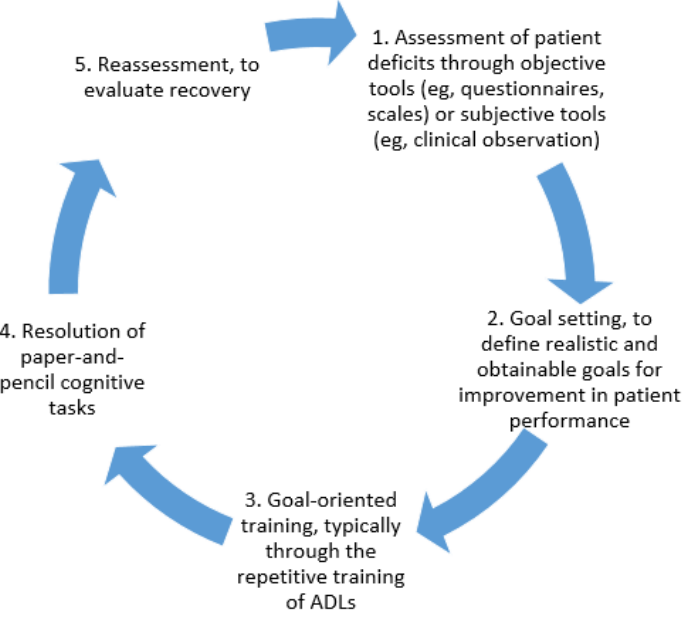
Figure 1. The process of traditional cognitive training programs (the figure was drawn based on descriptions provided by Vourvopoulos et al [8]). ADLs: activities of daily